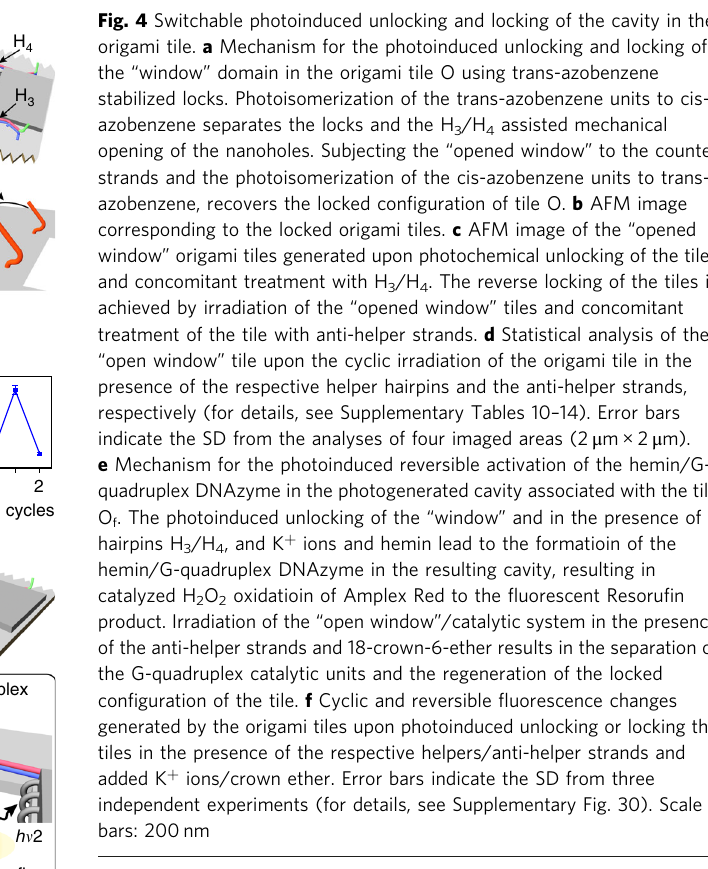
anchoring tethers, A 1 /A 2 , leading to the formation of H 3 /H 3a ′ /